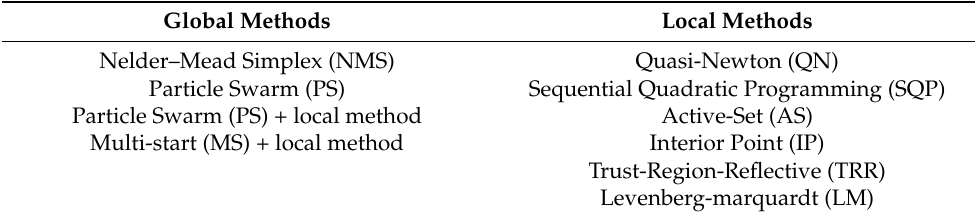
Table 1. Classification of optimisation methods considered in the